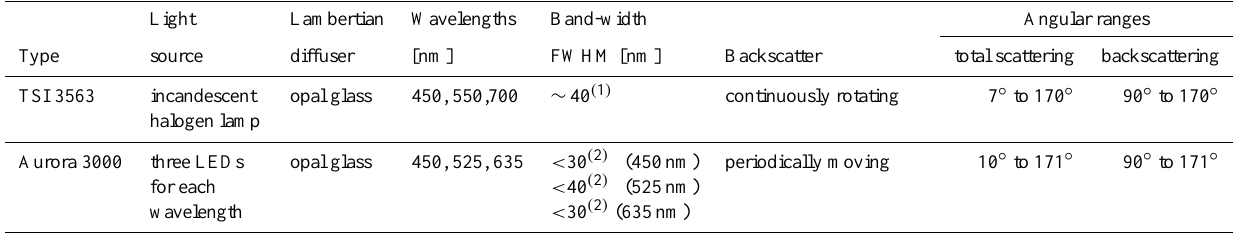
Table 1. Nephelometer specifications.